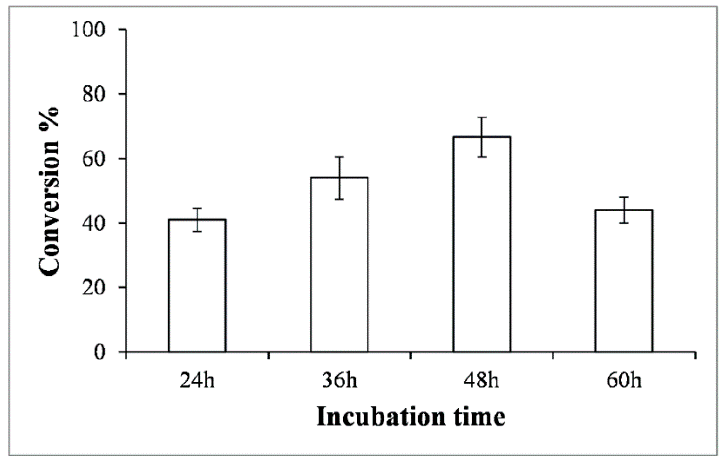
Figure 6. Percentage conversion of alizarin-2- O - β - D -glucoside in bioreactor at different incubation time intervals.